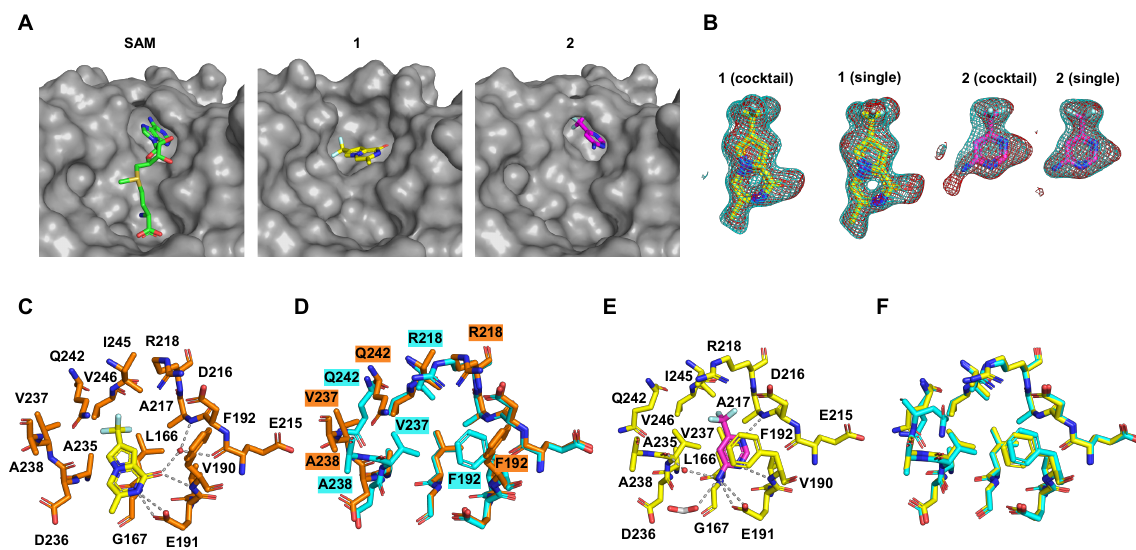
Figure 3. hFBL crystal structures with fragment hits. ( A ) Surface representation (grey) of the hFBL:SAM, hFBL: 1 and hFBL: 2 and complexes. The hFBL protein backbone is displayed in cartoon representation ( 1 , orange; 2 , yellow; SAM, cyan) while the ligands are shown in stick representation (1, yellow; 2, magenta; SAM, green). Oxygen, nitrogen, sulphur, and fluorine atoms are coloured in red, blue, light orange, and pale cyan, respectively. ( B ) Standard omit mFo-DFc (red mesh, contoured at 3.0 σ ) and polder (cyan mesh, contoured at 4.0 σ ) maps of 1 and 2 . ( C ) Stick representation of 1 and residues in the cofactor binding pocket of hFBL. ( D ) Superimposition of the hFBL:SAM and hFBL: 1 structures. Residues undergoing extensive rearrangements are labelled. ( E ) Stick representation of 2 and residues in the cofactor binding pocket of hFBL (citrate, grey). ( F ) Superimposition of the hFBL:SAM and hFBL: 2 structures.